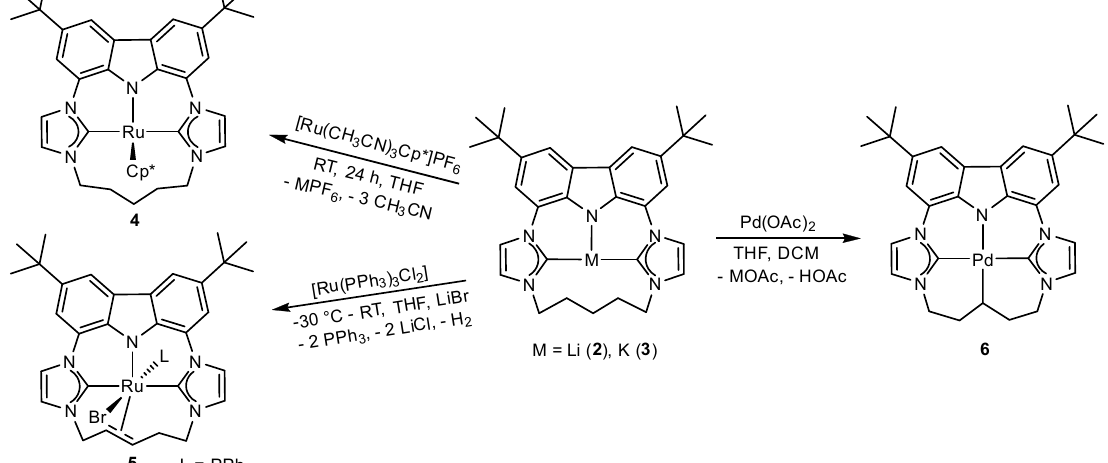
Scheme 2. Formation of Ru(II) and Pd(II) complexes with different coordination modes of the bimca C5 ligand from the in situ-generated alkali metal complexes 2 (Li) and 3 (K).